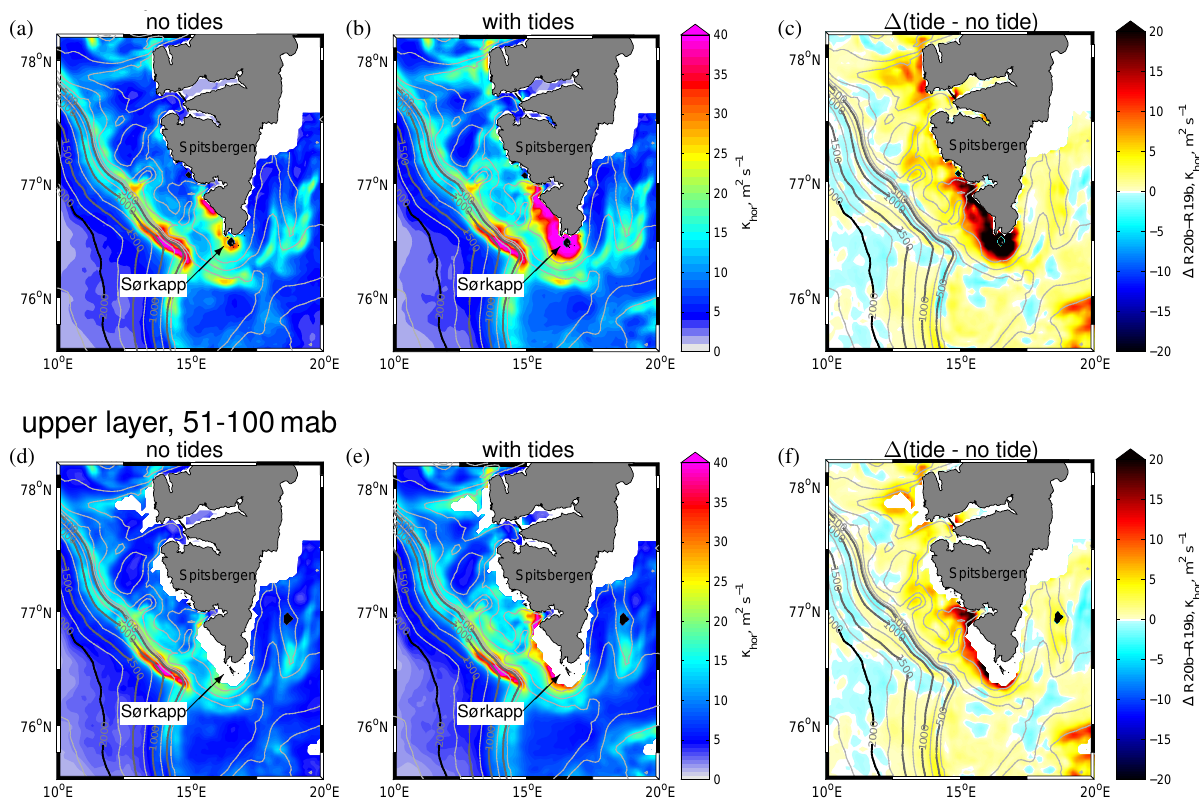
Fig. 7. Horizontal diffusivity coefficient κ hor in the bottom layer (0–50mab, metres above bottom) (a–c) and the upper layer (51–100mab) (d–f) . Values in (a) , (b) and (d) , (e) are averaged over the modelled overflow period from mid-January to end of August. The difference is shown in panels (c) and (f) – warm colours ranging to black represent a tidally induced increase in κ hor .